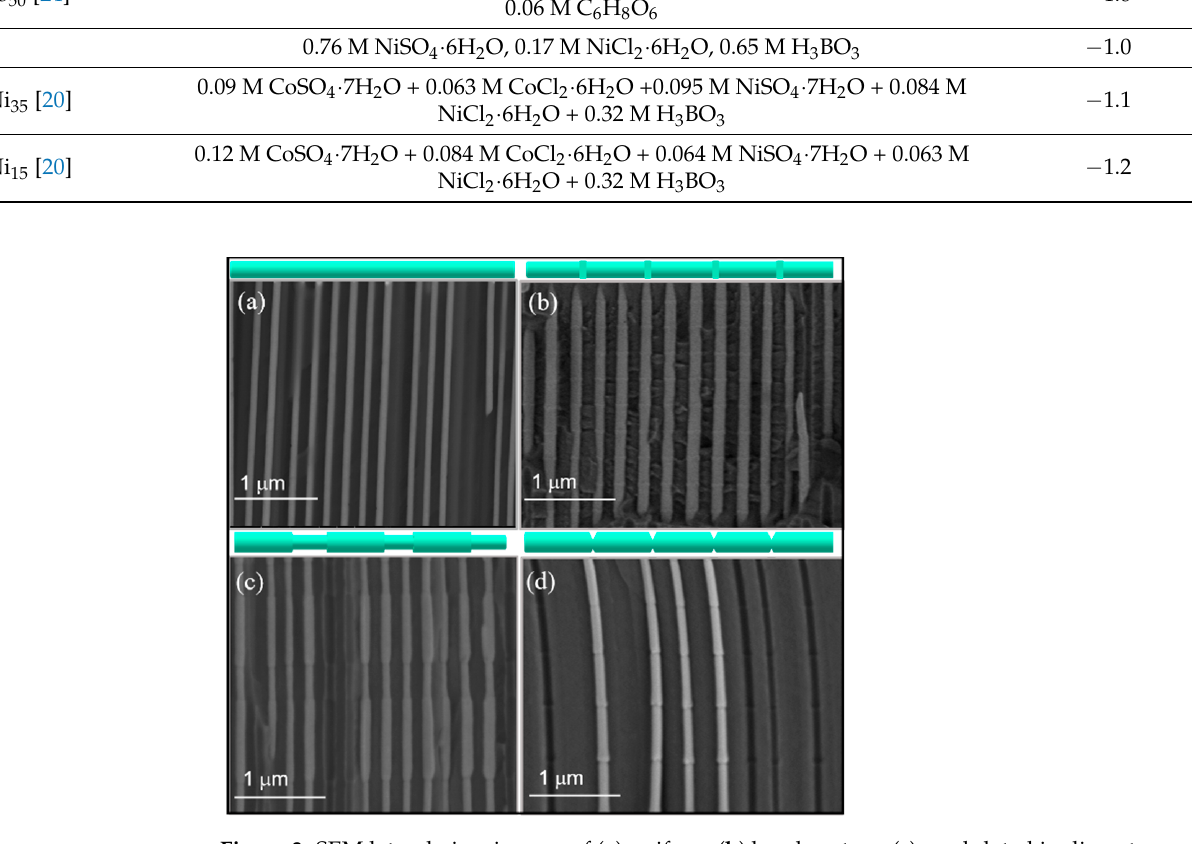
Figure 3. SEM lateral view images of ( a ) uniform ( b ) bamboo-type ( c ) modulated in diameter and ( d ) notched nanowires.